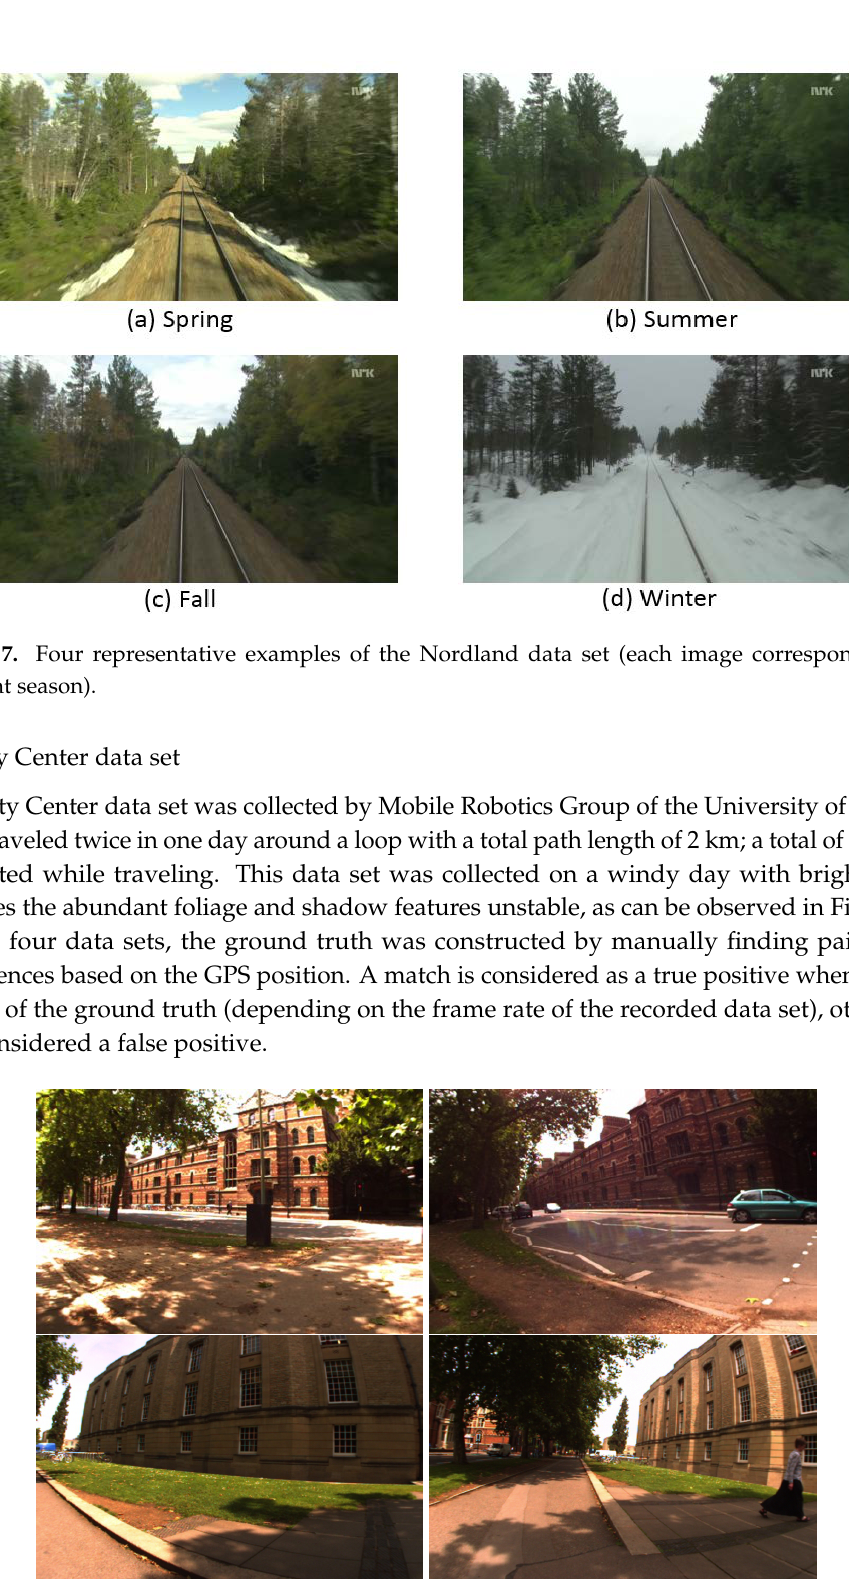
Figure 8. City Center data set [38]: twice traveling. The left column shows the training images, and the right column shows the testing